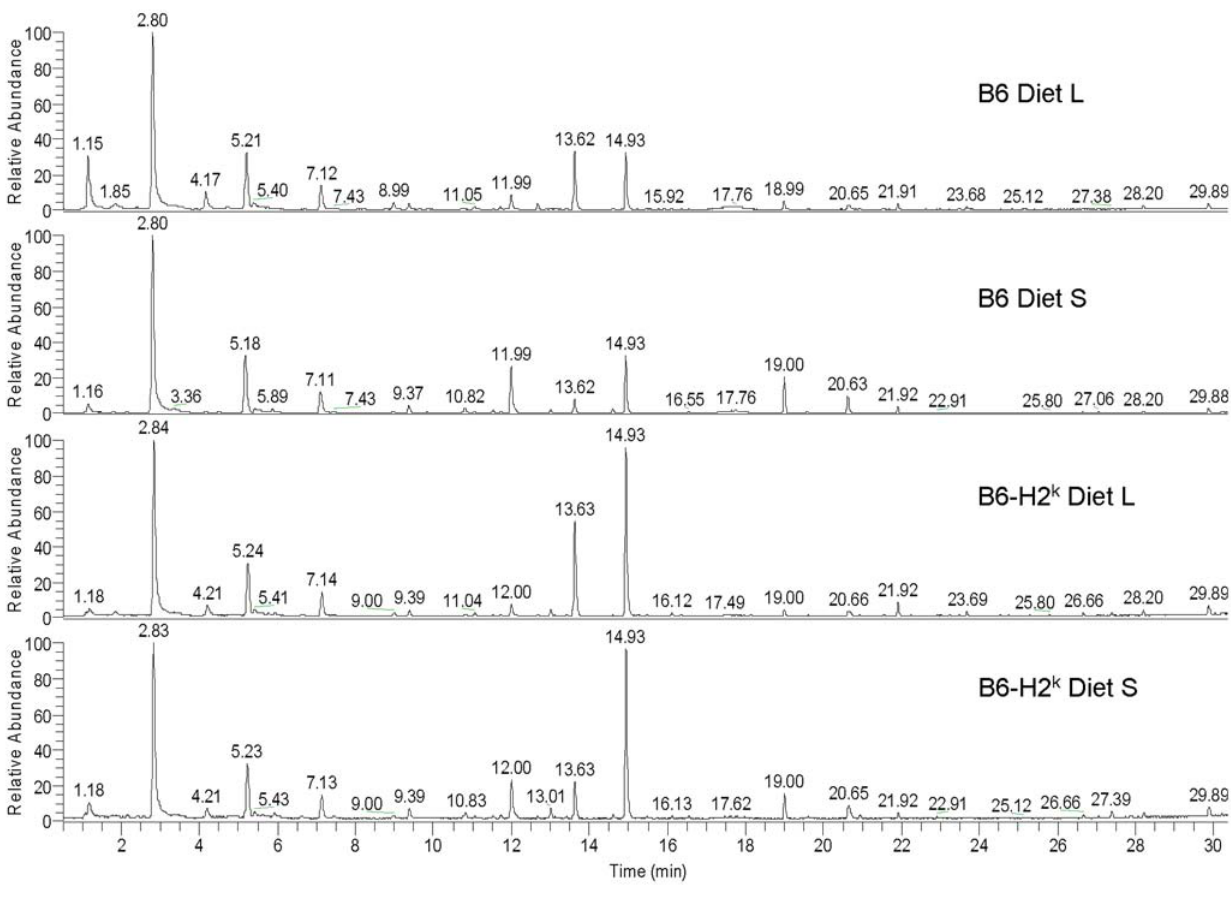
Figure 1. Typical total ion chromatograms from the urinary volatiles extracted from four mouse groups. One representative chromatogram each from B6 mice fed Diet L, B6 mice fed Diet S, B6-H2 K mice fed Diet L and B6-H2 K mice fed Diet S is shown here. Prominent compound peaks include 2-acetyl-1-pyrroline (11.99 min), beta-farnesene (19.00 min), alpha-farnesene (20.63 min), and the mouse pheromones 2,3- dehydro-exo-brevicomin (13.62 min) and 2-sec-butyl-4,5-dihydrothiazole (14.93 min).